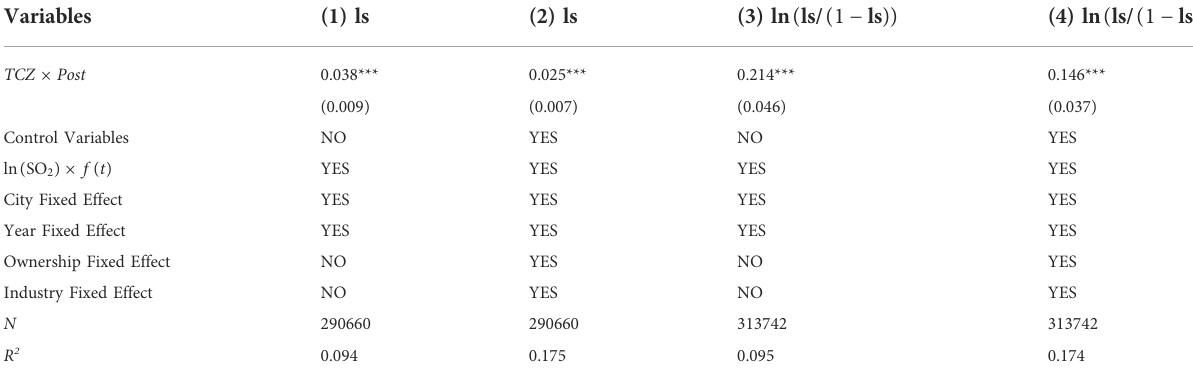
TABLE 3 Robustness